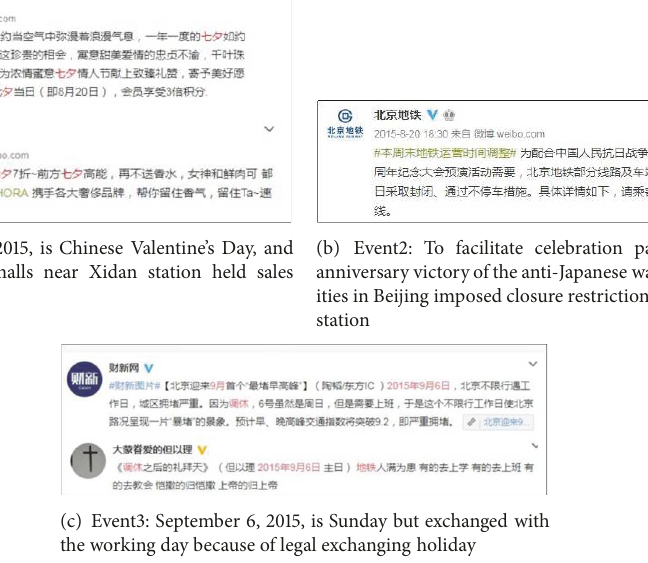
Figure 6: The events information sent by tweet users.